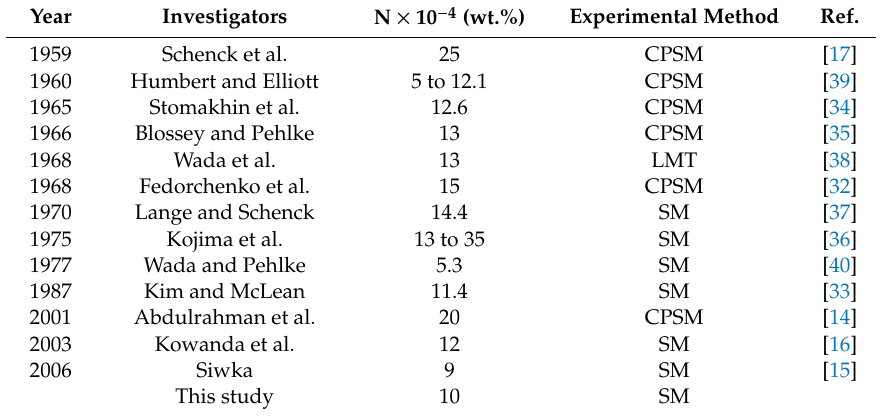
Table 3. Solubility of nitrogen in liquid nickel at 1873 K and 1.0 bar nitrogen partial